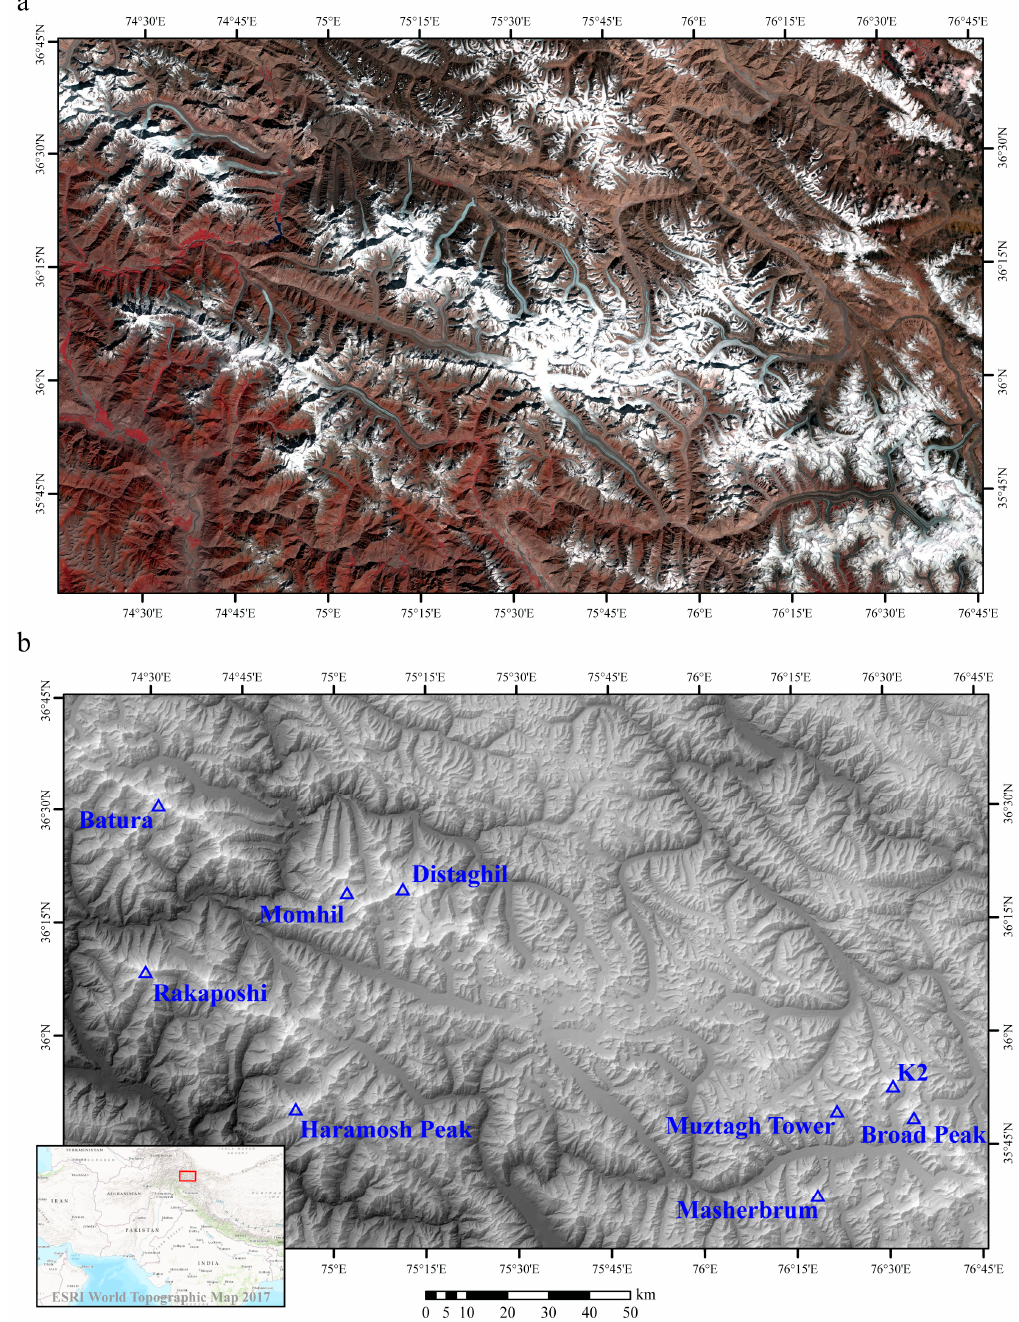
Figure 1. This map of the Karakoram Himalaya displays: a Landsat 8 false-color composite image ( a ); and a Shuttle Radar Topographic Mapping Mission (SRTM) based analytical shaded-relief map of the Karakoram with major peaks identified ( b ).